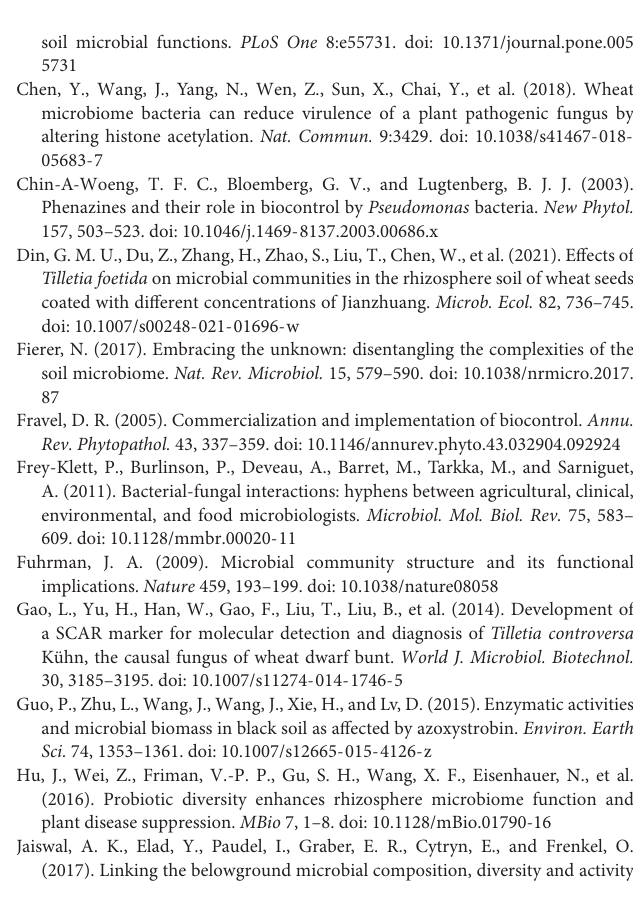
Supplementary Figure 1 | Molecular detection of T. controversa from the leaf samples using specific primers. M, DL2000 marker (100, 250, 500, 750, 1,000, and 2,000 bp); line 1, positive control; lines 5, 7, and 11, T. controversa- infected leaf samples; lines 2–4, 8–10, and 12, negative controls; black arrows indicate the target band of size 372 bp. Supplementary Figure 2 | (A) Shannon curves of different rhizosphere soil bacteria in T. controversa -infected and non-infected samples at the phylum level. (B) Shannon curves of different rhizosphere fungi in T. controversa -infected and non-infected samples at the phylum level. (C) Principal component analysis (PCA) of weighted UniFrac distances of bacterial communities. (D) Principal component analysis (PCA) of weighted UniFrac distances of fungal communities. Supplementary Figure 3 | (A) ANOVA test for bacterial community. (B) ANOVA for fungal community. Supplementary Table 1 | Sequence analysis of the samples after T. controversa